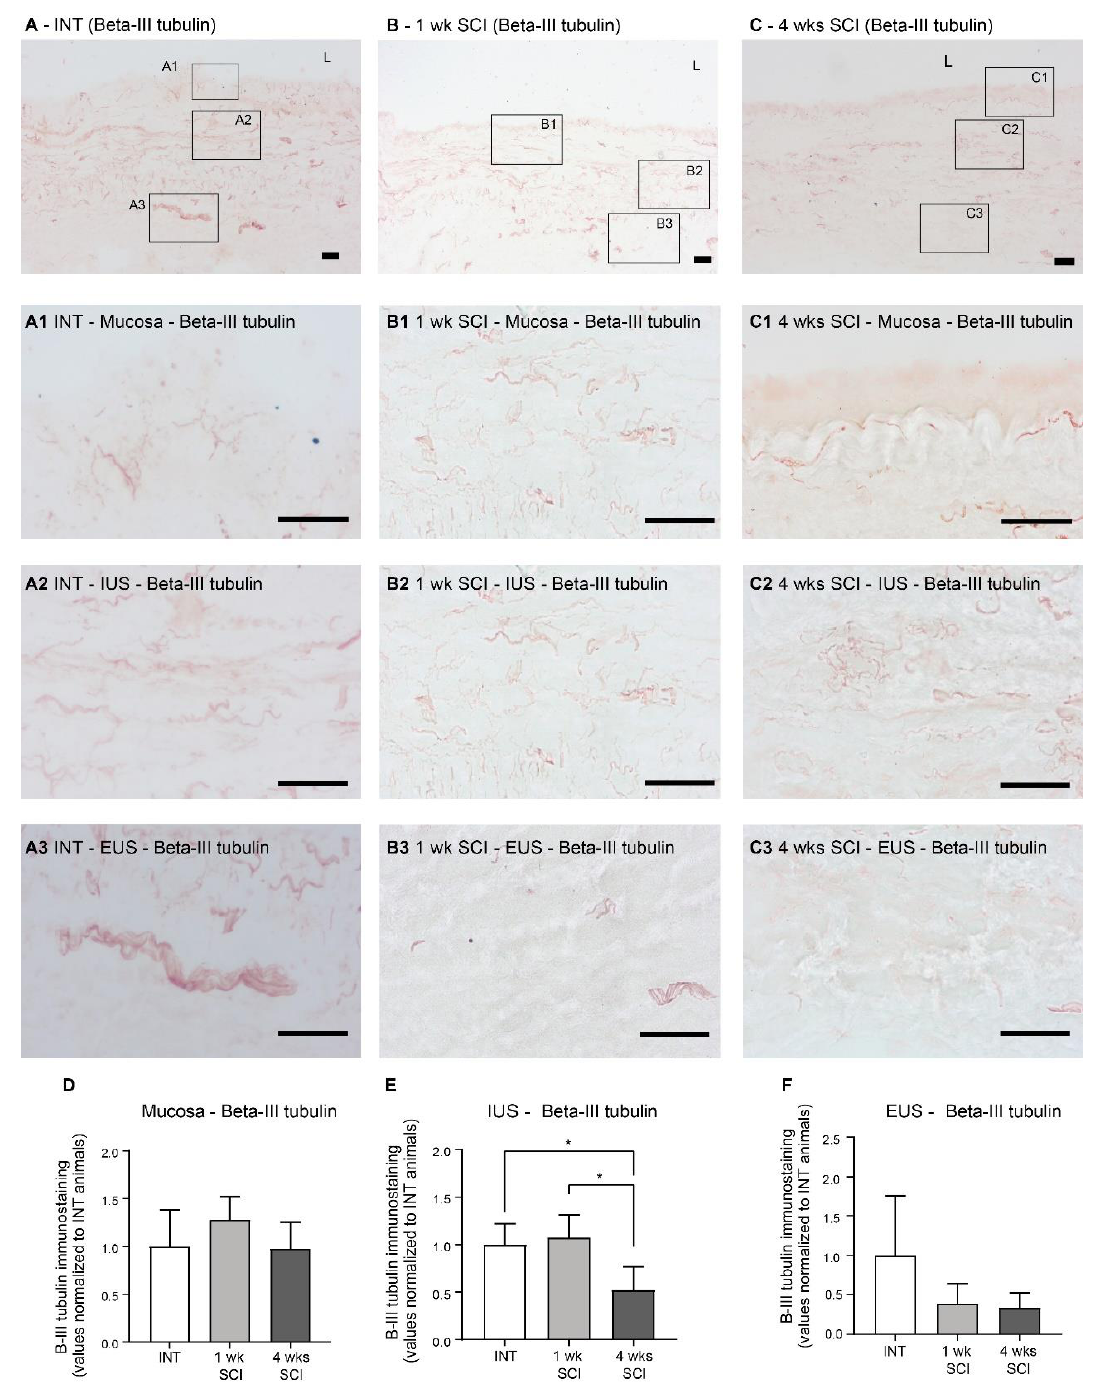
Figure 5. Immunolabeling of β -III tubulin in the proximal urethra. The general neuronal content was assessed using the ABC method for the detection of β -III tubulin, which stained the overall population of neuronal fibers in the urethral wall. Spinal intact animals ( A ) presented fibers widely distributed along the wall, in the mucosa ( A1 ), in the internal urethral sphincter (IUS) ( A2 ), and in the external urethral sphincter (EUS; A3 ). One-week SCI animals ( B ) presented an evident denervation in the EUS ( B3 ) but not in the mucosa ( B1 ) and IUS ( B2 ). Animal lefts to recover 4-weeks post-SCI ( C ) presented denervation both in IUS ( C2 ) and EUS ( C3 ) but not in the mucosa ( C1 ). Scale bars equal 50 μm. The quantification of labeling intensity by Image J in the mucosa ( D ), IUS ( E ), and EUS ( F ) ( n = 5). One-way ANOVA followed by Tukey’s multiple comparison test (* p < 0.05 versus spinal intact